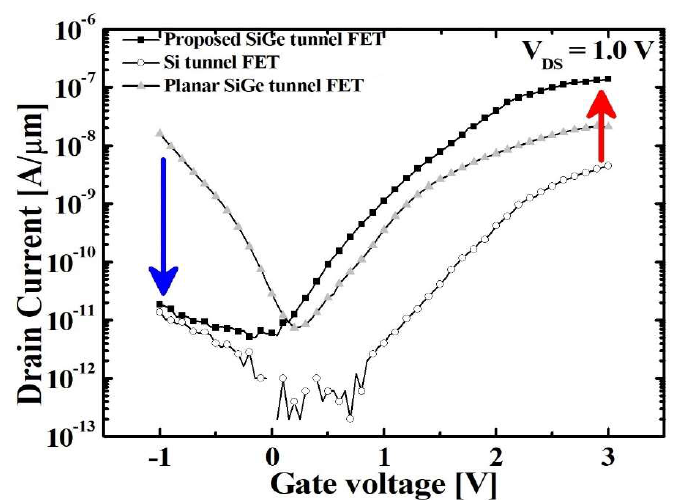
Figure 8. Transfer characteristics of the proposed TFET and conventional planar TFETs with Si and SiGe channels.